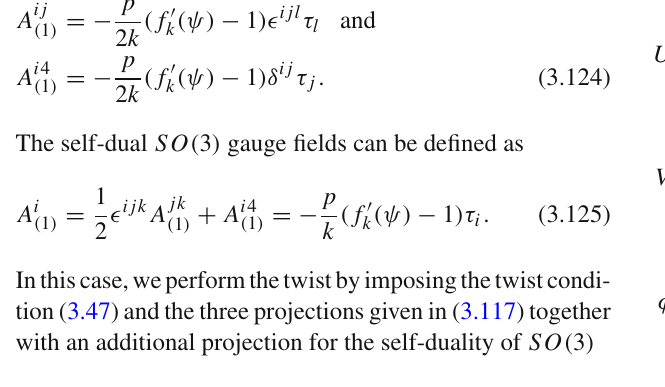
, − 1 ),( 1 , − 1 ),( 1 , − 1 ),( 1 , − 1 ) , 34 34 34 26 24 18 36 8